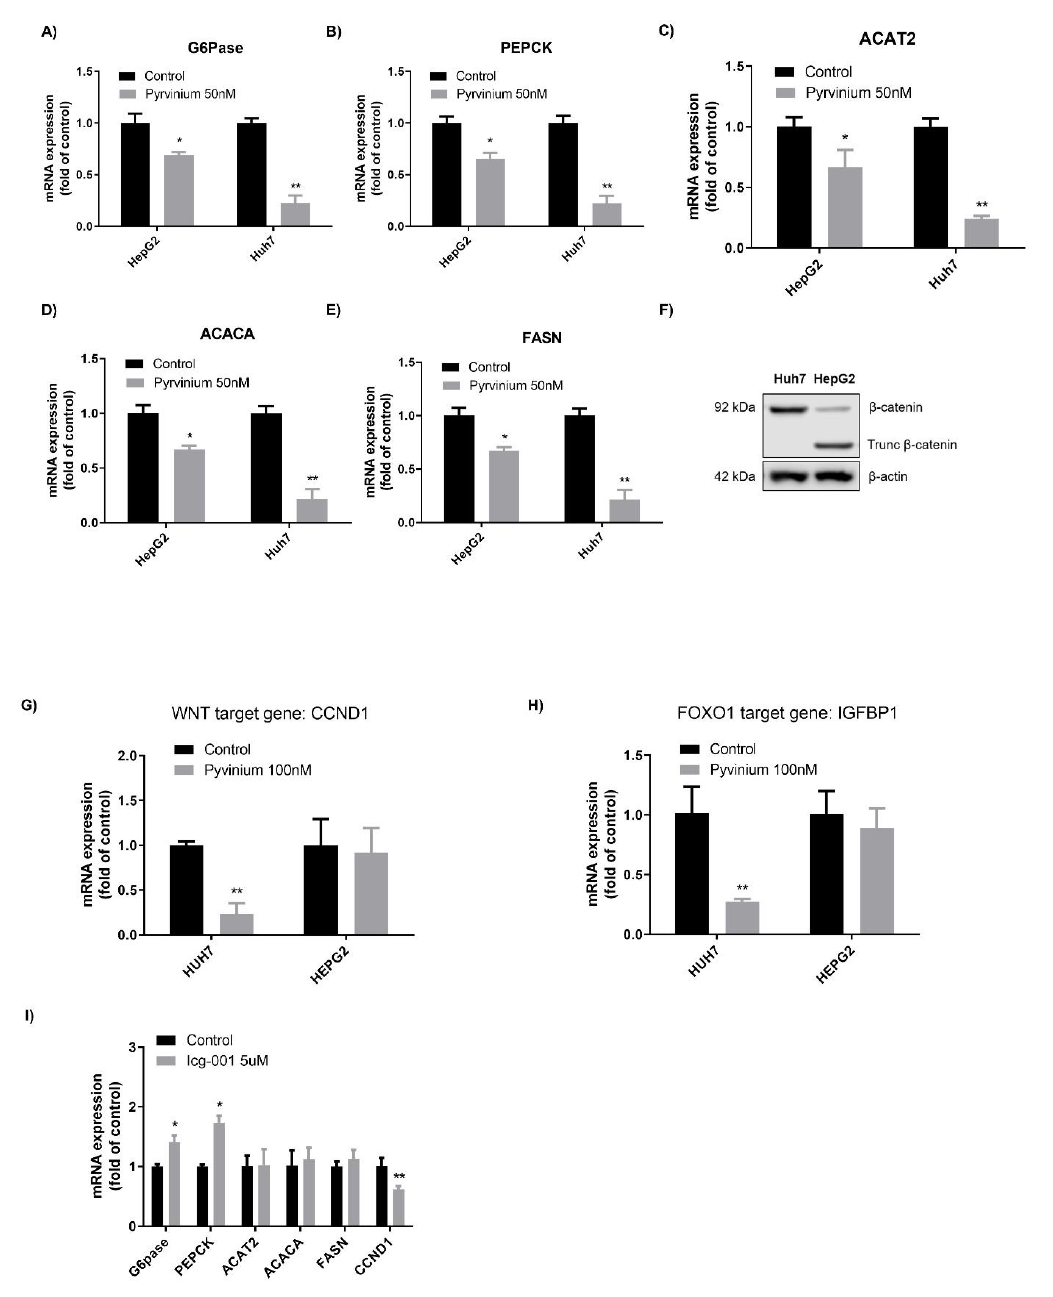
Figure 3. Comparison of pyrvinium effects on gene expression between Huh7 and HepG2 cells. ( A – E ) Relative mRNA expression of gluconeogenic genes G6Pase ( A ), PEPCK ( B ) and lipogenic genes ACAT2 ( C ), ACACA ( D ), and FASN ( E ) in HepG2 and Huh7 cells treated with 50 nM pyrvinium for 48 h in the medium containing 1g/L glucose ( A , B ) or in normal medium containing 200 µ M oleate ( C – E ). ( F ) Differential protein expression of β -catenin forms in Huh7 and HepG2 cells. ( G ) Relative mRNA expression of Wnt target gene CCND1 (encoding Cyclin D1) and ( H ) β -catenin/FOXO1 target gene IGFBP1 in Huh7 and HepG2 cells treated with pyrvinium100 nM for 24 h. ( I ) Relative mRNA expression of gluconeogenic and lipogenic genes and Wnt target gene CCND 1 in Huh7 cells treated with 5 µ M ICG-001 for 24 h. * p < 0.05; ** p < 0.01. Data are representative of at least three independent